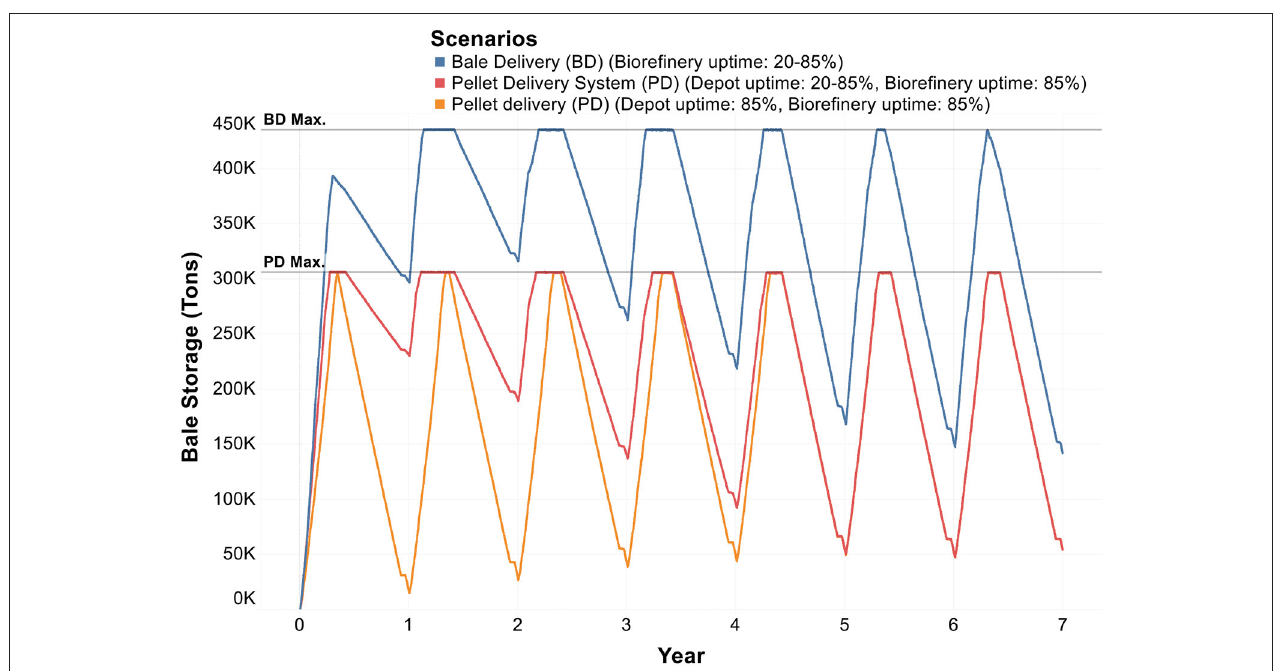
FIGURE 7 | Corn stover bale storage (tonnage) for the bale-delivery (Biorefinery uptime: 20–85%), pellet-delivery (Depot uptime: 20–85%, Biorefinery uptime: 85%) and pellet-delivery (Depot uptime: 85%, Biorefinery uptime: 85%) scenarios.